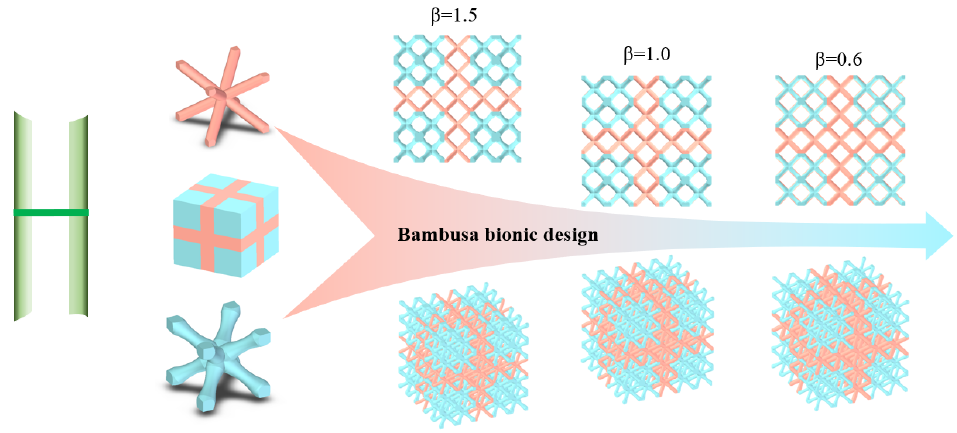
Figure 8. Three Bambusa-la tt ice structures.